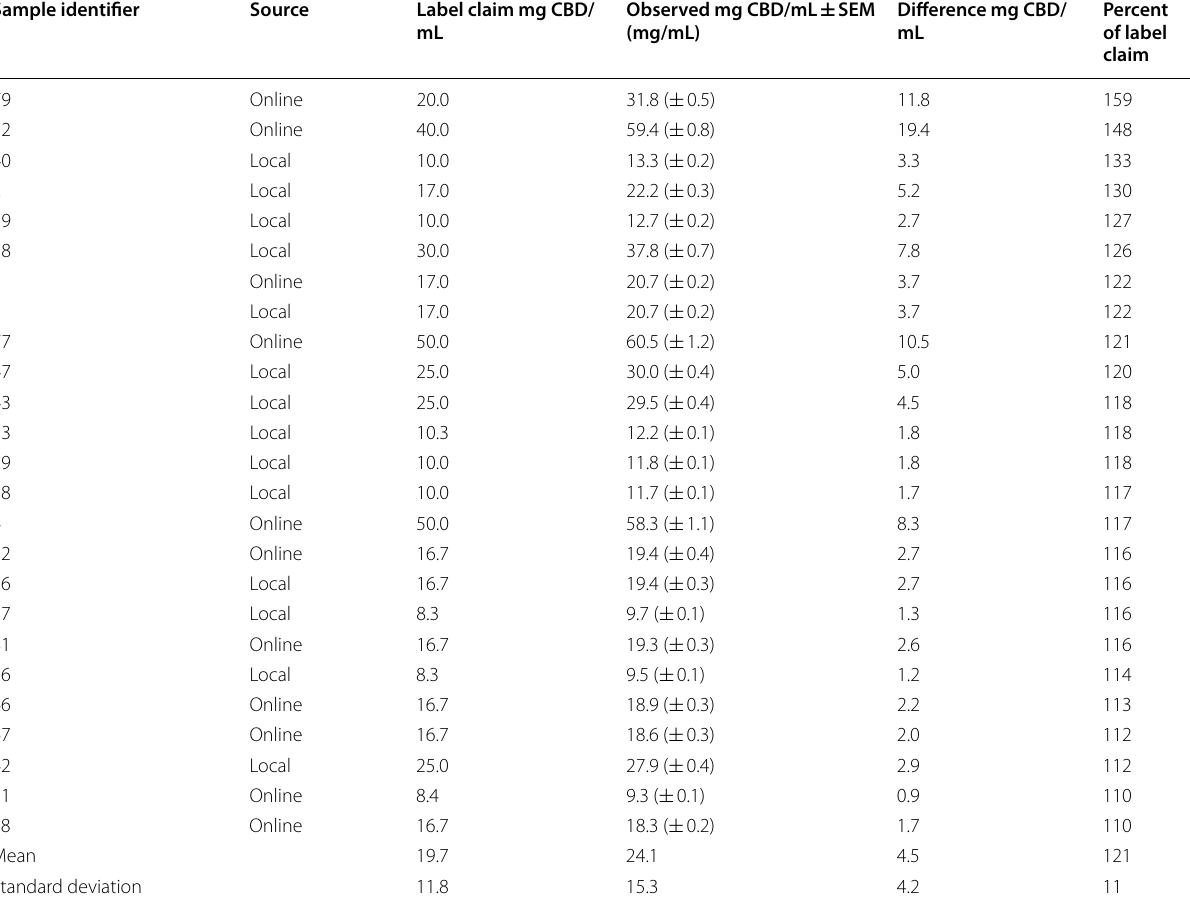
Table 2 List of samples containing at least 10% more CBD than label claim (i.e., under-labelled samples) Sample identifier